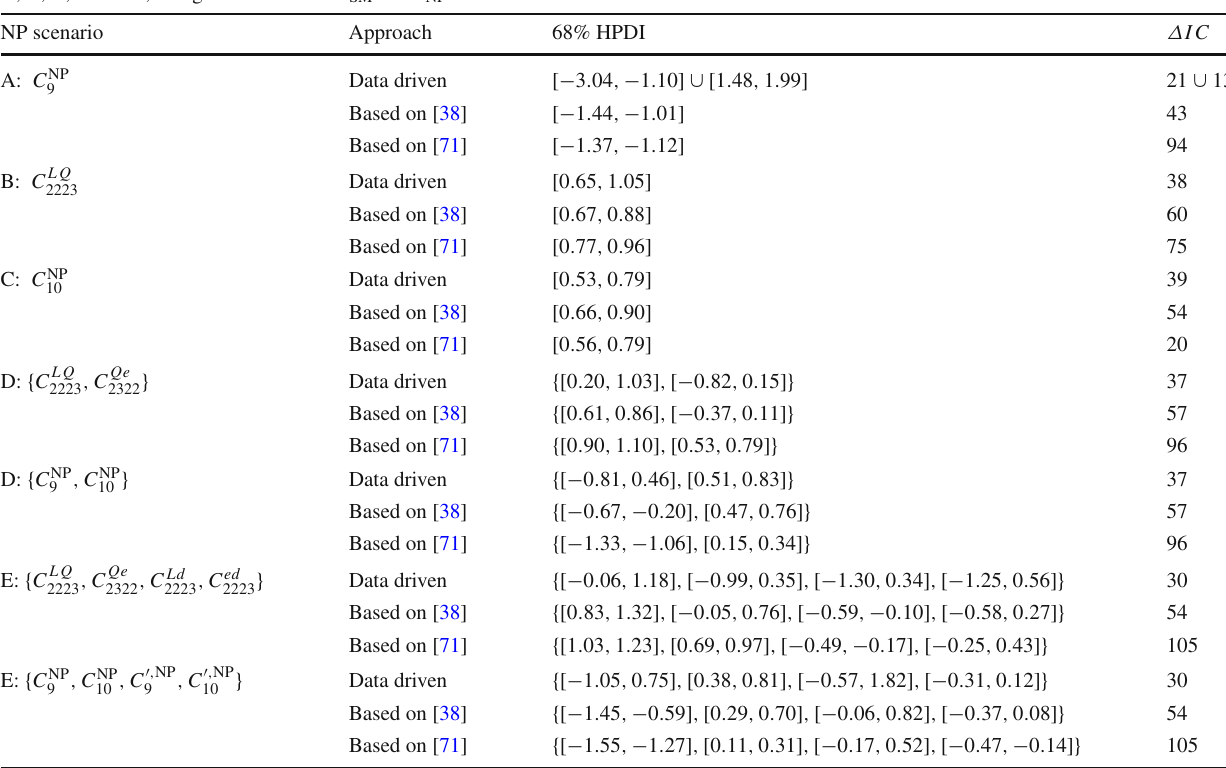
Table 2 68% HPDI of the posterior distribution of the SMEFT Wilson coefficients from a fit to the full set of b → s (cid:2) + (cid:2) − data in the NP scenarios A, B, C, D and E, along with Δ IC ≡ IC SM − IC